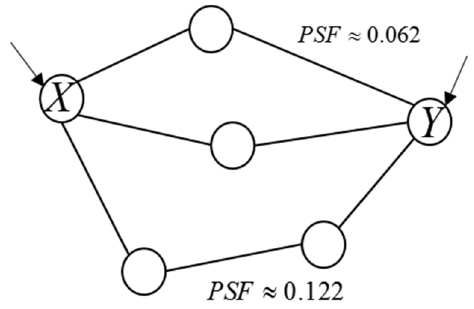
Figure 11. The schematic diagram of the central node.